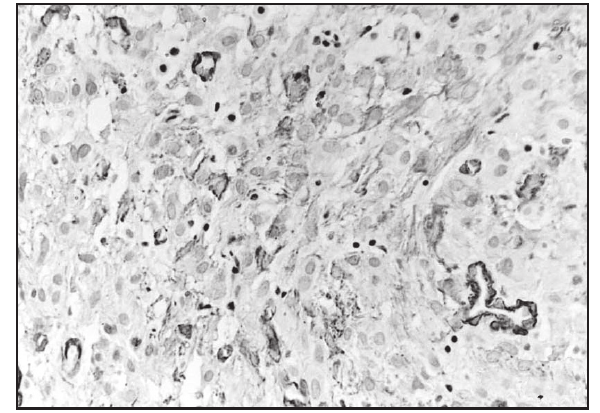
Figura 9 – Caso 1/AML. Todas as células neoplásicas exibindo marcação fortemente positiva para o anticorpo (100x)